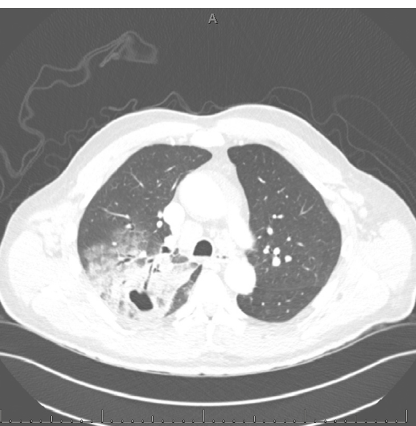
Figure 1: Contrast-enhanced computed tomography of the chest showing a cavitary mass with associated ground glass opacities and pneumonia.